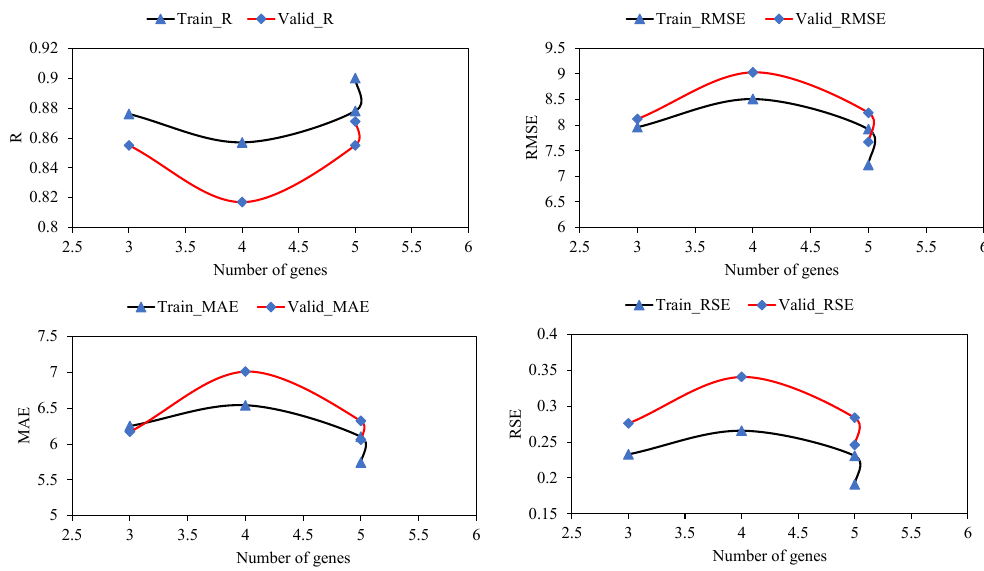
Figure 5. Effect of head size on statistical evaluation of the developed GEP models.